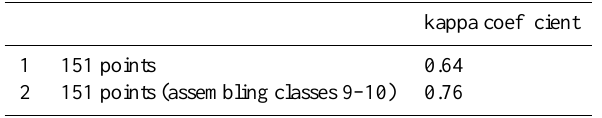
Table 6. Cohen’s kappa coefficient for the Congo Basin vegetation types map.